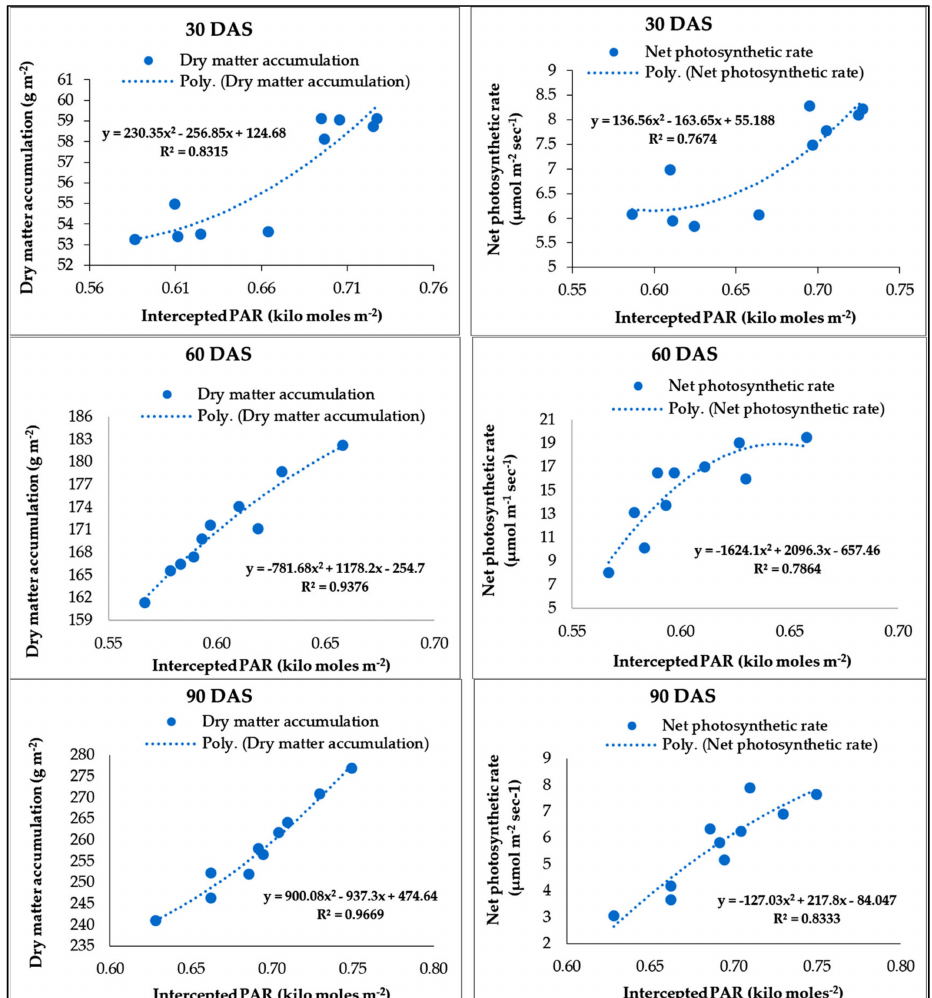
Figure 6. Impact of intercepted PAR on dry matter accumulation and net photosynthetic rate of grass pea.